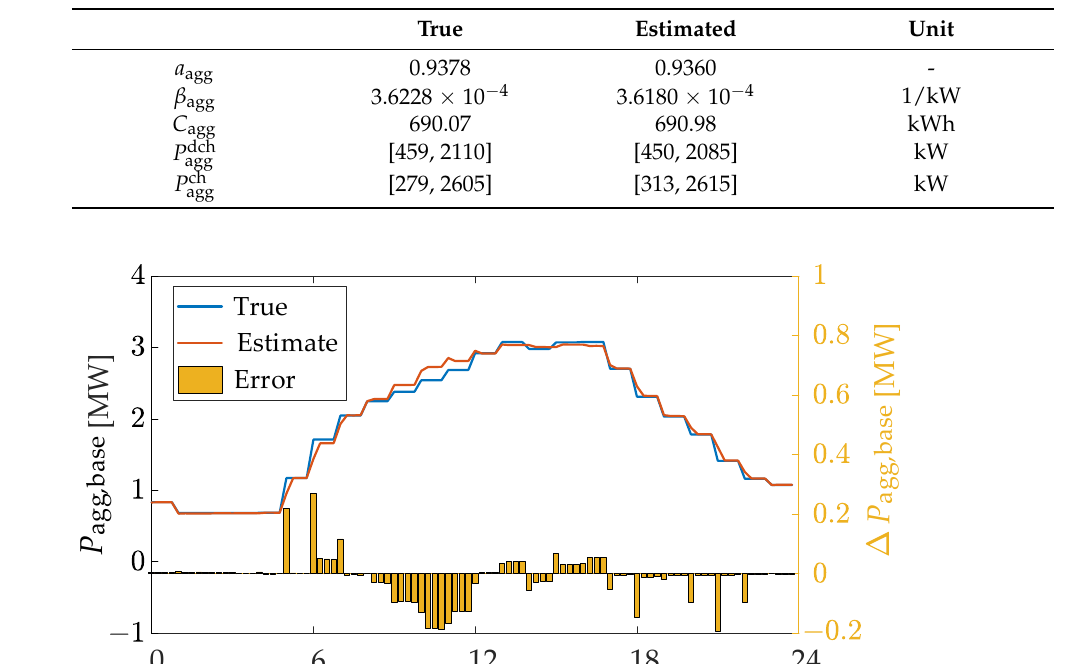
Table 4. Aggregate virtual battery model parameters.